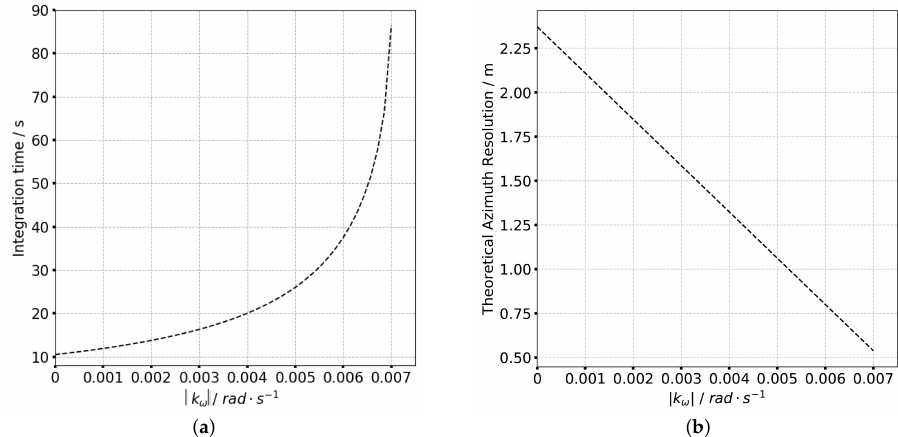
Figure 2. The integration time and azimuth resolution of P-band sliding spotlight mode as function of k ω . ( a ) Integration time. ( b ) Theoretical azimuth